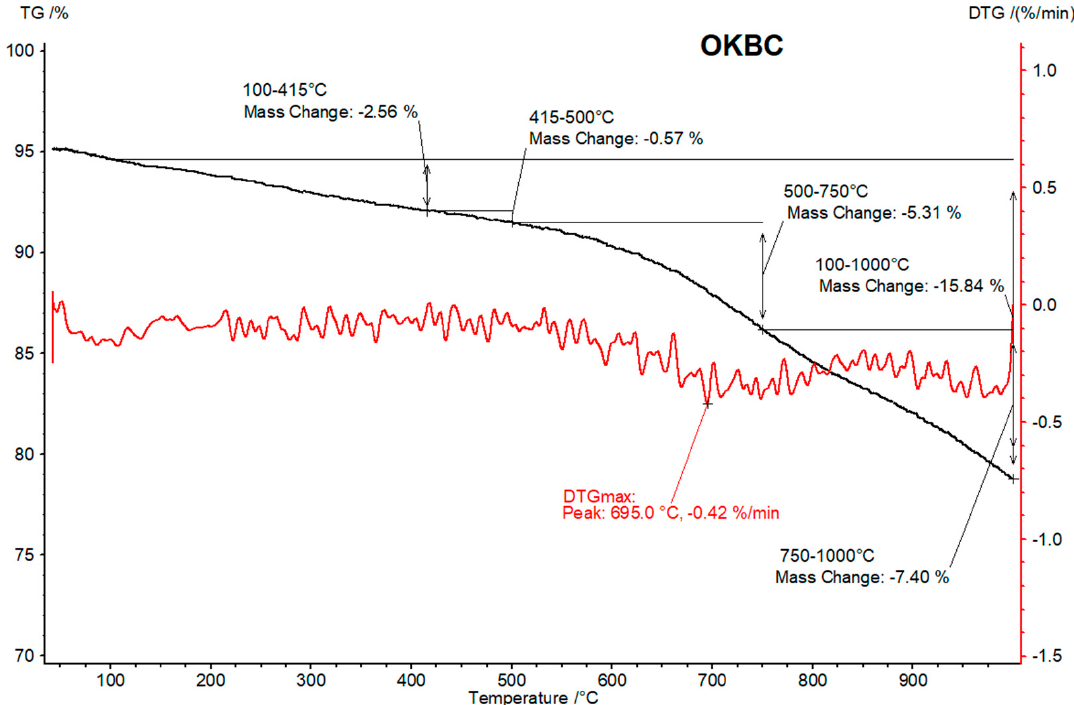
Figure A9. TG/DTG curves obtained for olive kernel biochar.